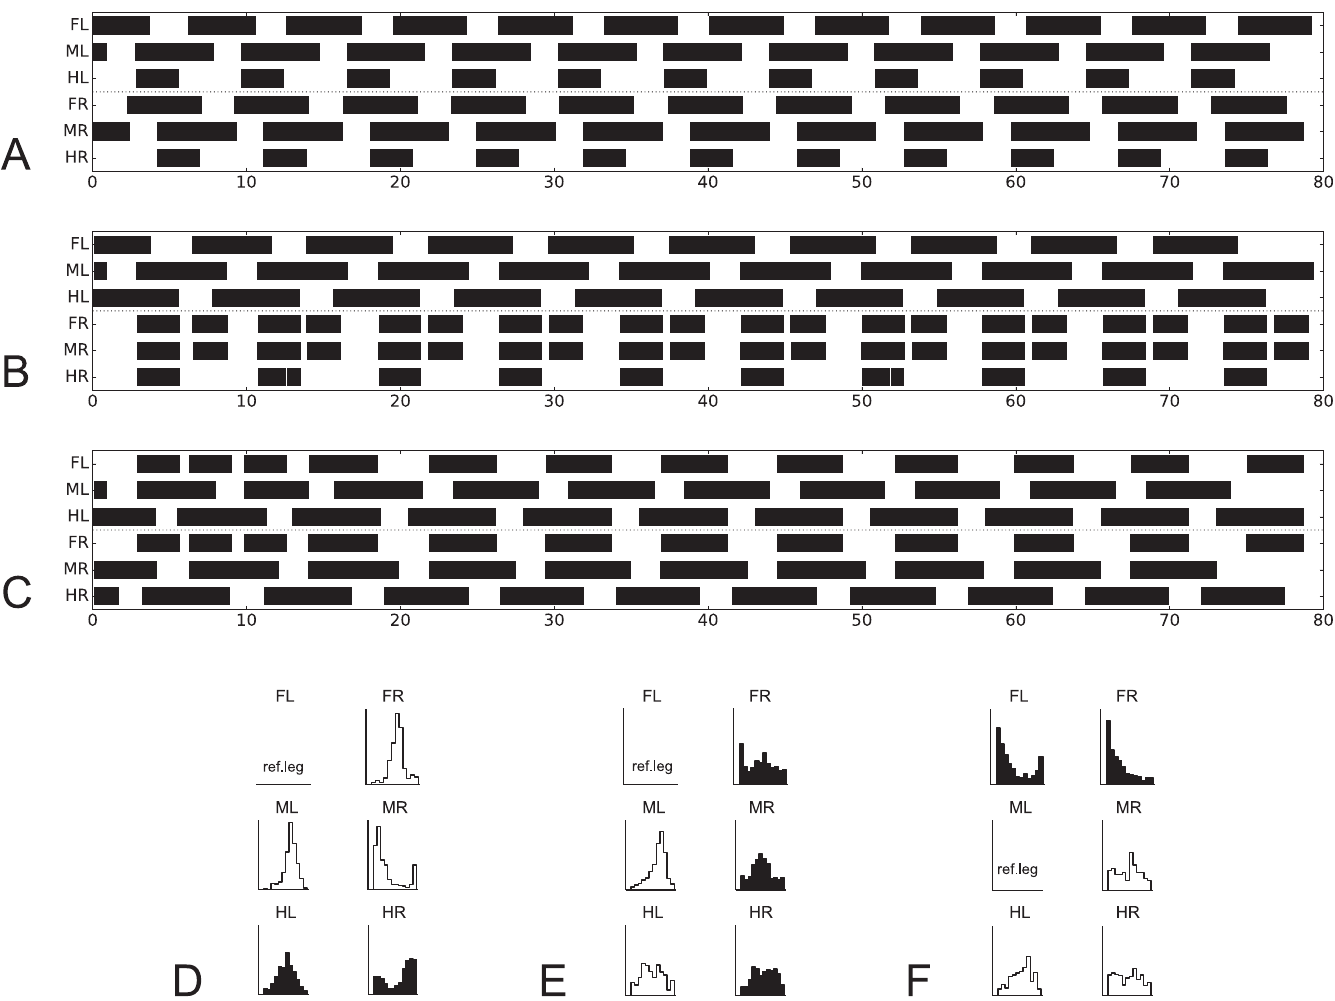
Fig 10. Simulation of experiments where stick insects walk tethered on a treadmill with selected legs standing on force transducer platforms. Shown are activations of retractor motor neurons ( > 7 mV) over time (s) in A) to C). Corresponding experimental results [76,86] are given in D, E, F, respectively: Phase histograms of the beginning of the retraction in the walking legs (shown in white), force histograms of the maximum force in the standing legs (dark). Reference leg starting with the beginning of the retraction movement. In A) and D) both front legs and both middle legs are walking while both hind legs are standing. B) and E) shows left legs walking and right legs standing. C) and F) show both front legs standing, both middle legs and both hind legs walking [76,86]. Walking velocity neurons set to 30 mV.